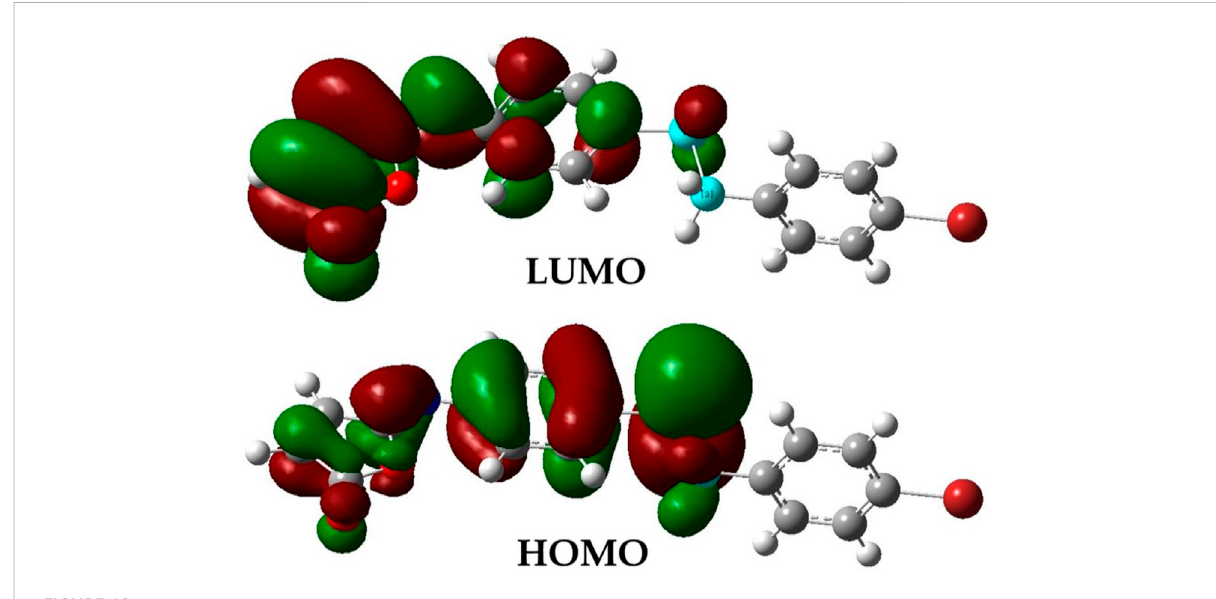
FIGURE 10 Electronic distribution of LUMO and HOMO molecular orbitals of the isomaleimide 4 .